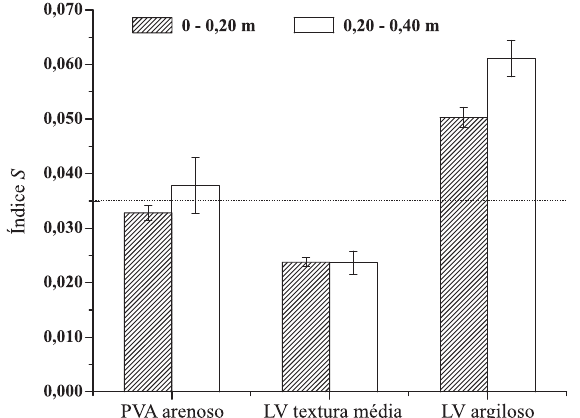
Figura 4. Valores médios de S dos três solos estudados. As barras indicam o intervalo de confiança (95